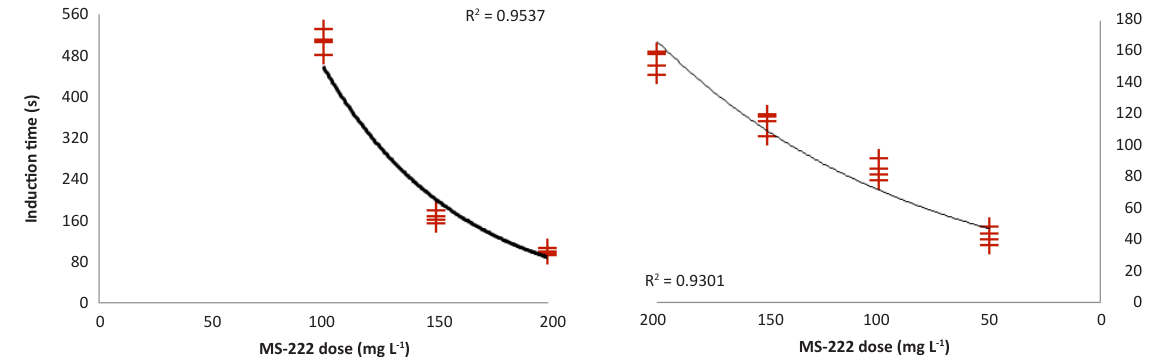
Figure 1. Induction time and recovery time in relation to MS-222 concentrations (mg L -1 ) in Puntius denisonii (P<0.05,